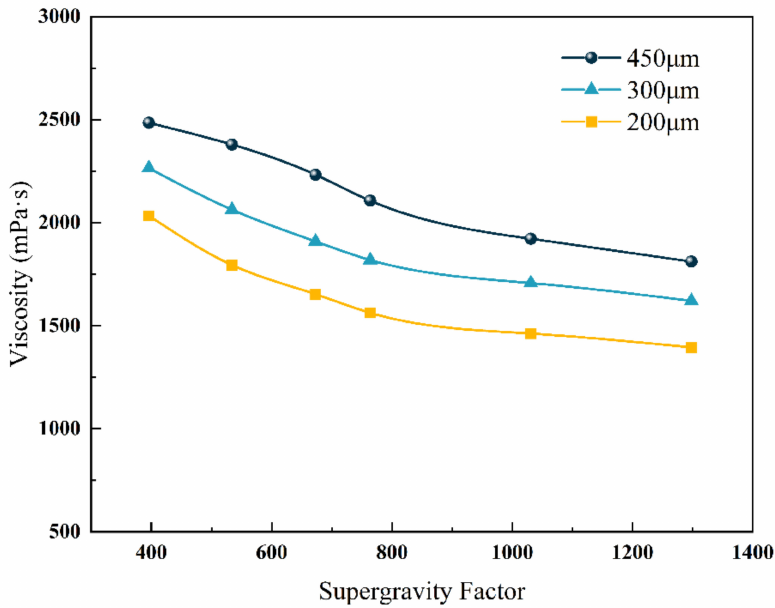
Figure 11. Variation curve of super-gravity factor versus solution viscosity for different packing pore